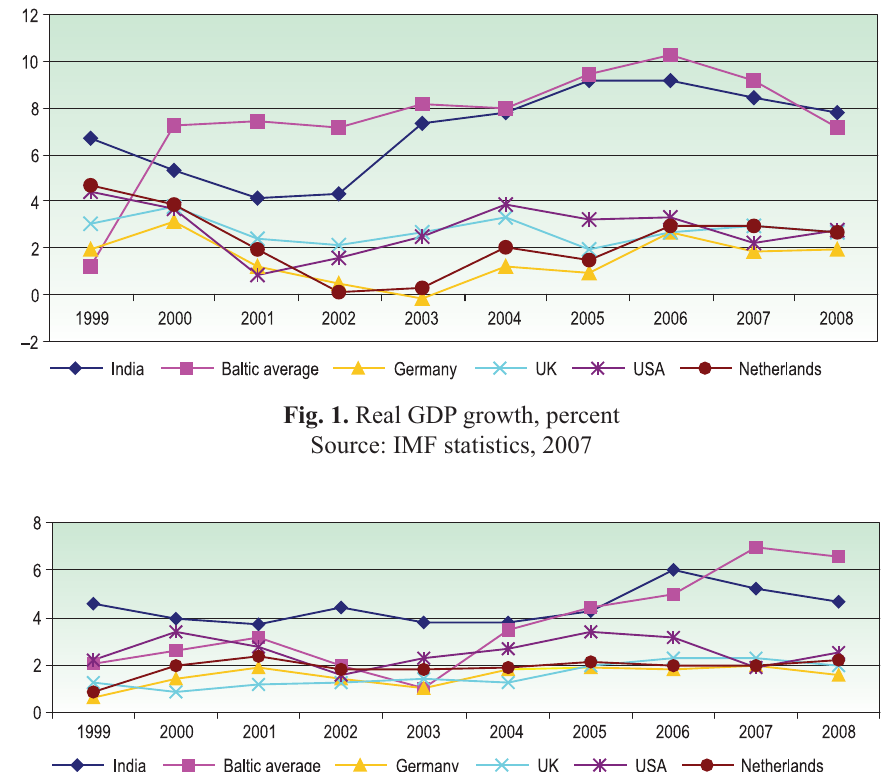
Fig. 2. Consumer price infl ation, percent Source: IMF statistics,